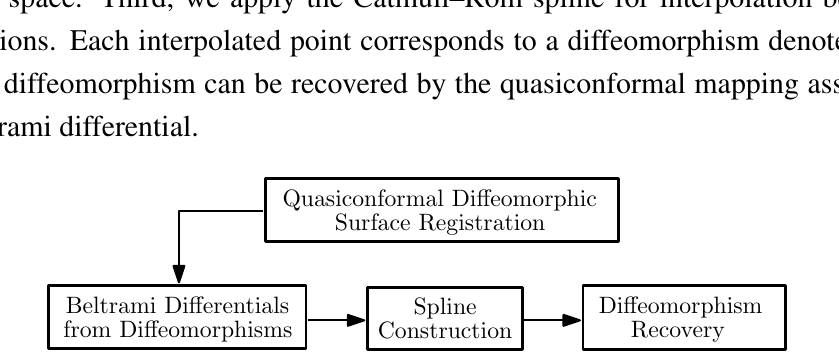
Figure 3. Pipeline for computing the spline of